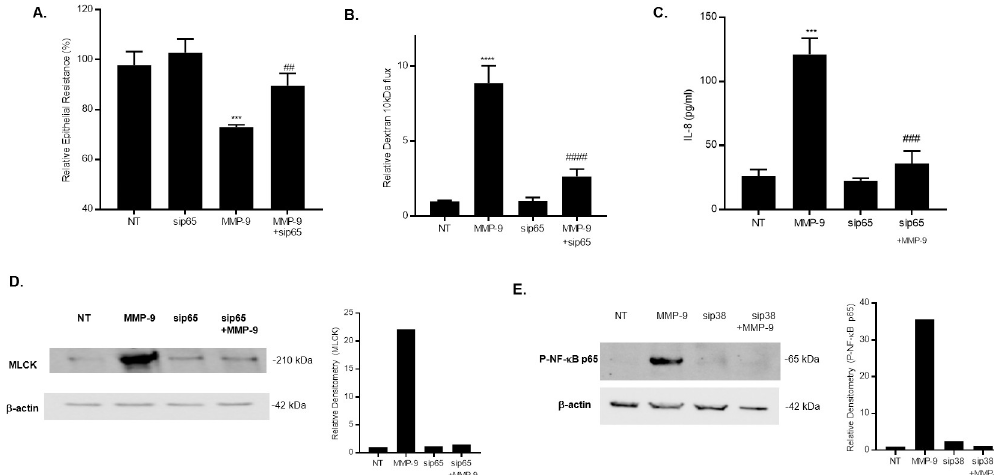
Fig 3. Effect of NF- κ B inhibition on MMP-9 induced increase in Caco-2 TJ permeability and increase in MLCK expression. (A) NF- κ B p65 siRNA transfection prevented the MMP-9-induced drop in Caco-2 TER and (B) increase in dextran 10 kDa flux (n = 4). ��� P < 0.001 vs control; ## P < 0.01 vs MMP-9 treatment; ���� P < 0.0001 vs control; #### P < 0.0001 vs MMP-9 treatment. (C) MMP-9 treatment resulted in a significant increase in NF- κ B target gene IL-8. NF- κ B p65 siRNA prevented the IL-8 production by Caco-2 monolayers after MMP-9 treatment (24 hrs). IL-8 secretion was determined by collecting and centrifuging the media and then assayed by ELISA-based kit. ��� P < 0.0001 vs control; ### P < 0.001 vs. MMP-9 treatment. (D) Knocking-down NF- κ B p65 inhibited the MMP-9 induced increase in MLCK protein expression as assessed by western blot analysis. (NT; non-target siRNA). (E) Silencing p38 kinase by siRNA transfection prevented the MMP-9-induced activation of NF- κ B p65 as assessed by phosphorylation of p65. Caco-2 monolayers were transfected with p38 kinase siRNA for a 72-hr time period and then treated with MMP-9 for 1 hr, (NT; not-target siRNA).